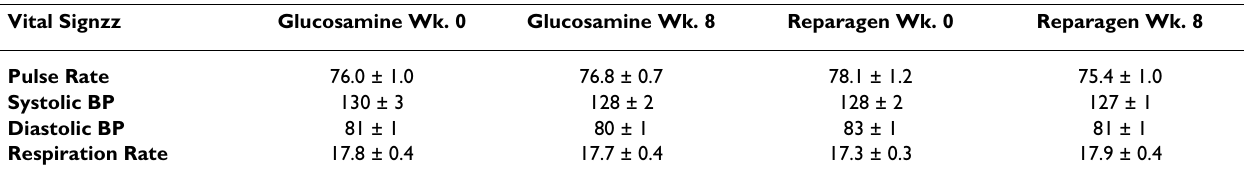
Table 3: Vital Signs